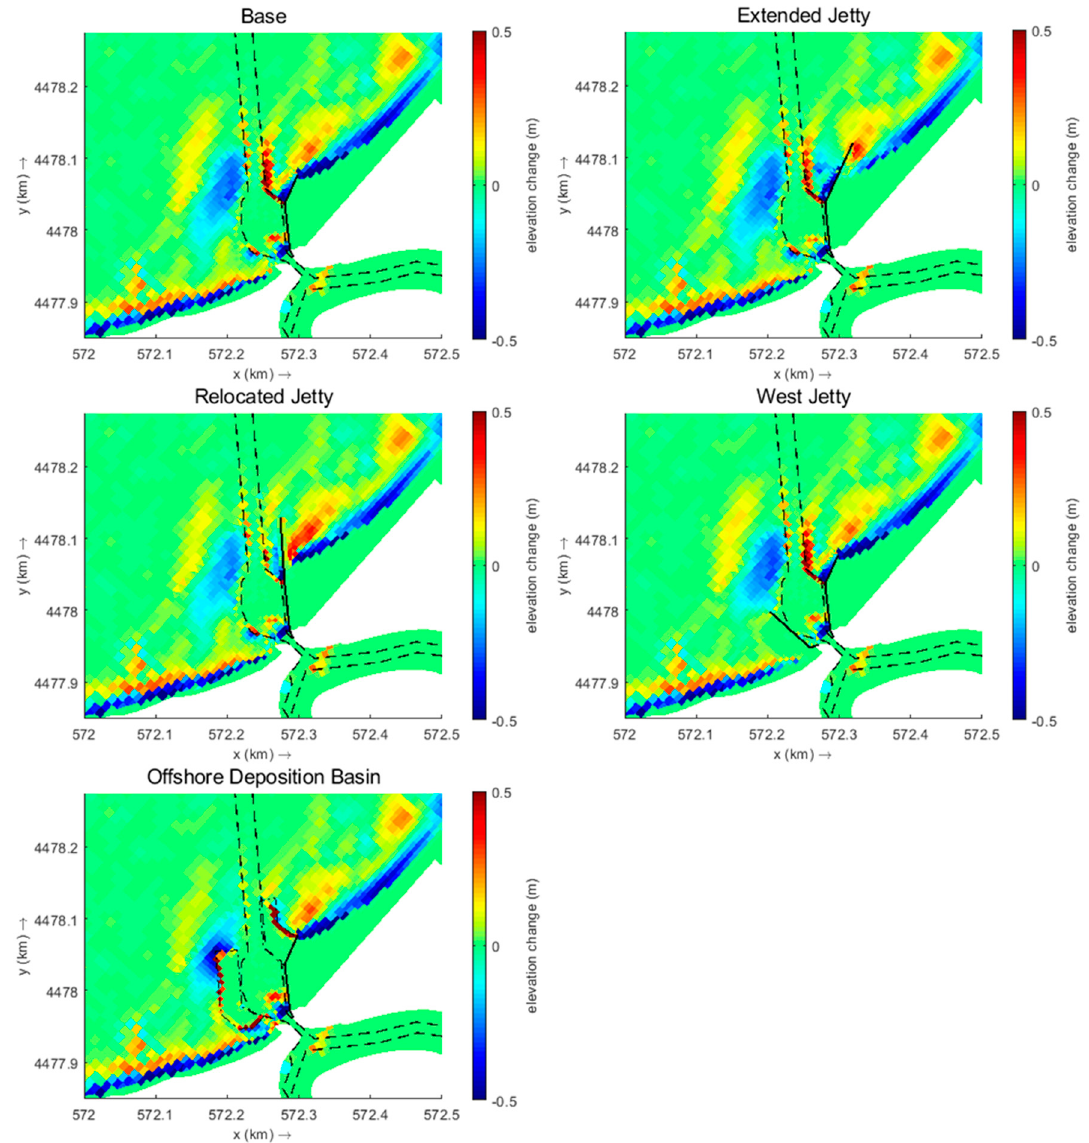
Figure 11. Cumulative sedimentation/erosion for modeled period (28 days): NNE Storm. Area of interest/channel limits by dashed line, jetty by solid black line, and deposition basins by the dot and dashed line.